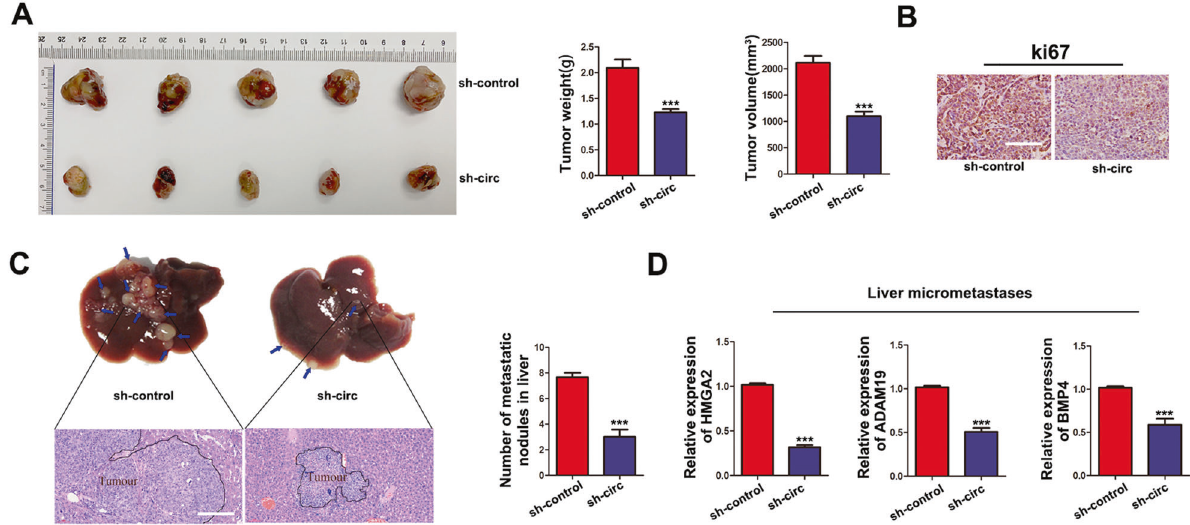
Fig. 7 Knockdown of circPABPC1 suppresses CRC growth and liver metastasis in vivo. A Subcutaneous tumor formation was used to detect the effect of circPABPC1 on cell proliferation ability in vivo. B Ki-67 protein levels were measured by immunohistochemistry analysis in subcutaneous tumor tissues. C A liver metastasis model was used to measure cell invasion in vivo. D The expression of several genes was detected by qRT – PCR in liver micrometastasis. Scale bar = 200 μ m. Quantitative data from three independent experiments are shown as the mean ± SD (error bars). * P < 0.05, ** P < 0.01, *** P < 0.001 (Student ’ s t test).